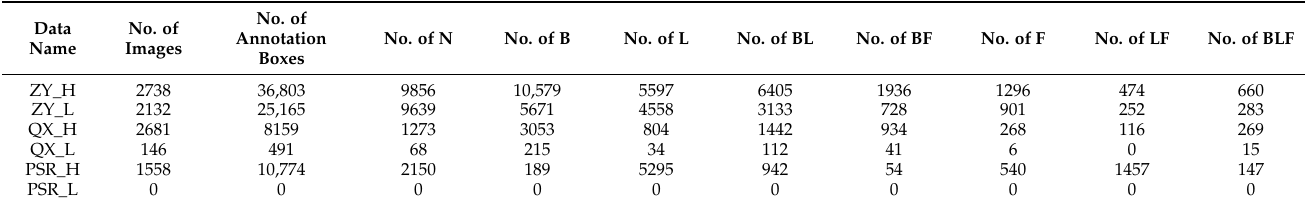
Table 2. Table 2. MTOA dataset statistics by high and low